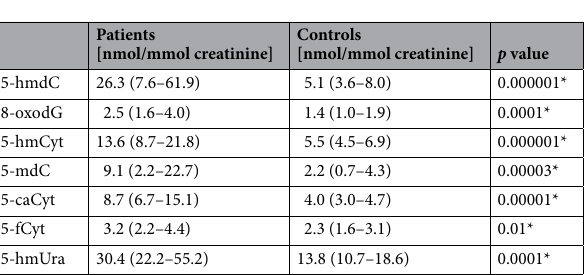
Table 1. Urinary levels of DNA damage markers and active demethylation products of 5-methylcytosine. The results are presented as median values with interquartile ranges (* p <